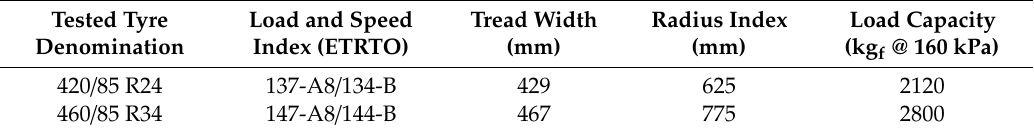
Table 1. Nominal characteristics of the tested